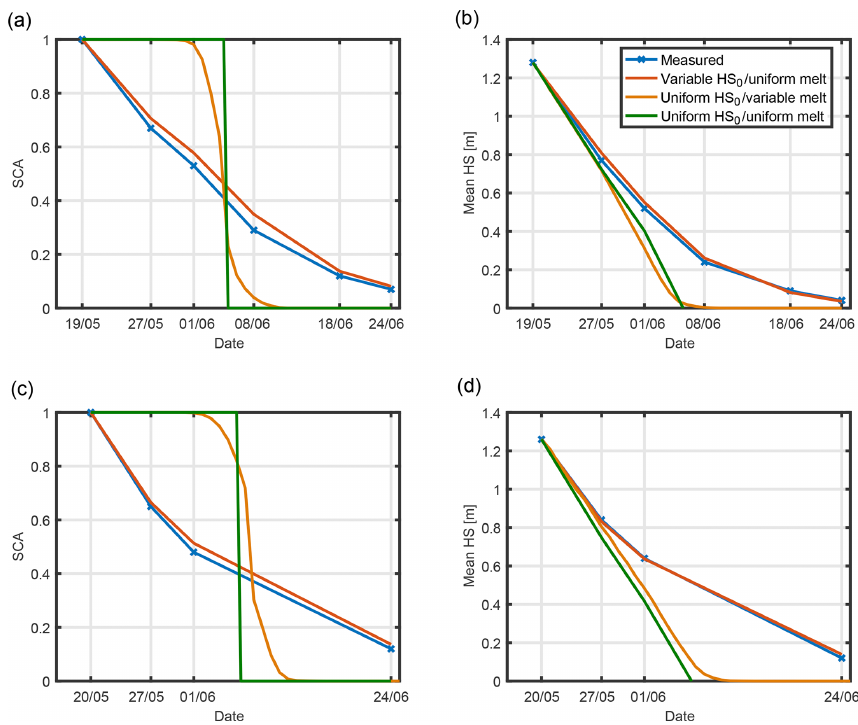
Figure 6. SCD and mean HS ablation for subarea N (a, b) and the total area (c, d) : blue represents measured values, red represents modelled values initialised with measured HS distribution on 19 May and uniform melt, and green represents modelled values initialised with uniform snow depth distribution and uniform